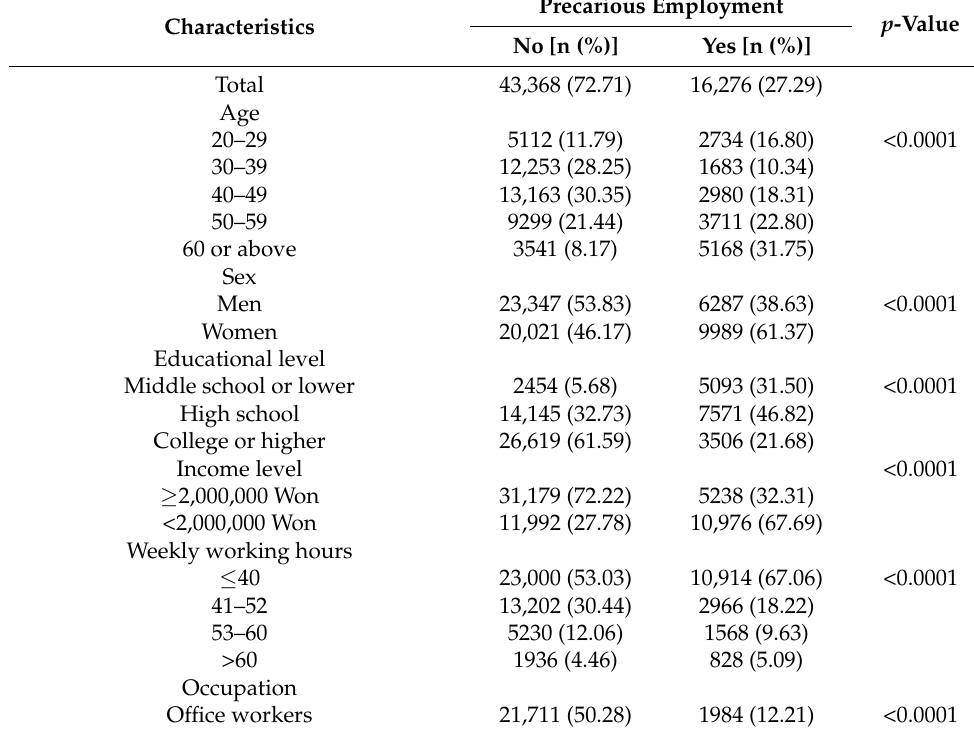
Table 1. General characteristics and working conditions by precarious employment.